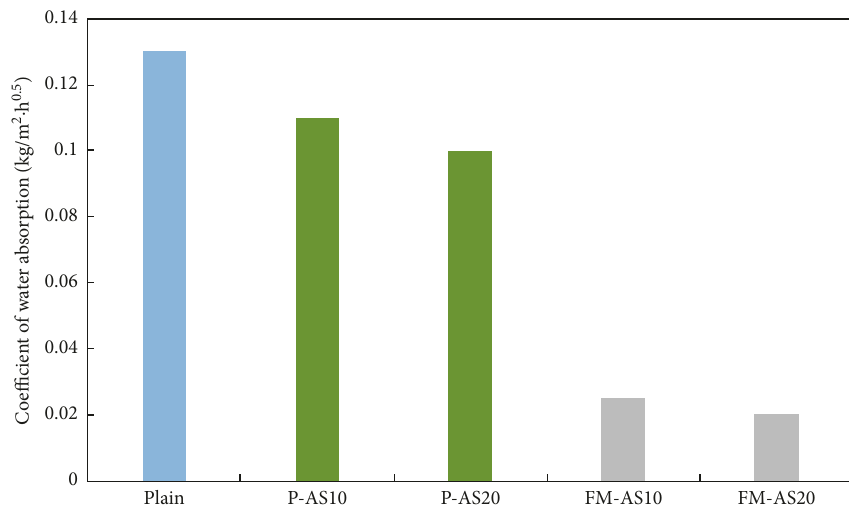
Figure 12: Coefficient of water absorption of the atomizing slag-modified RMAP.